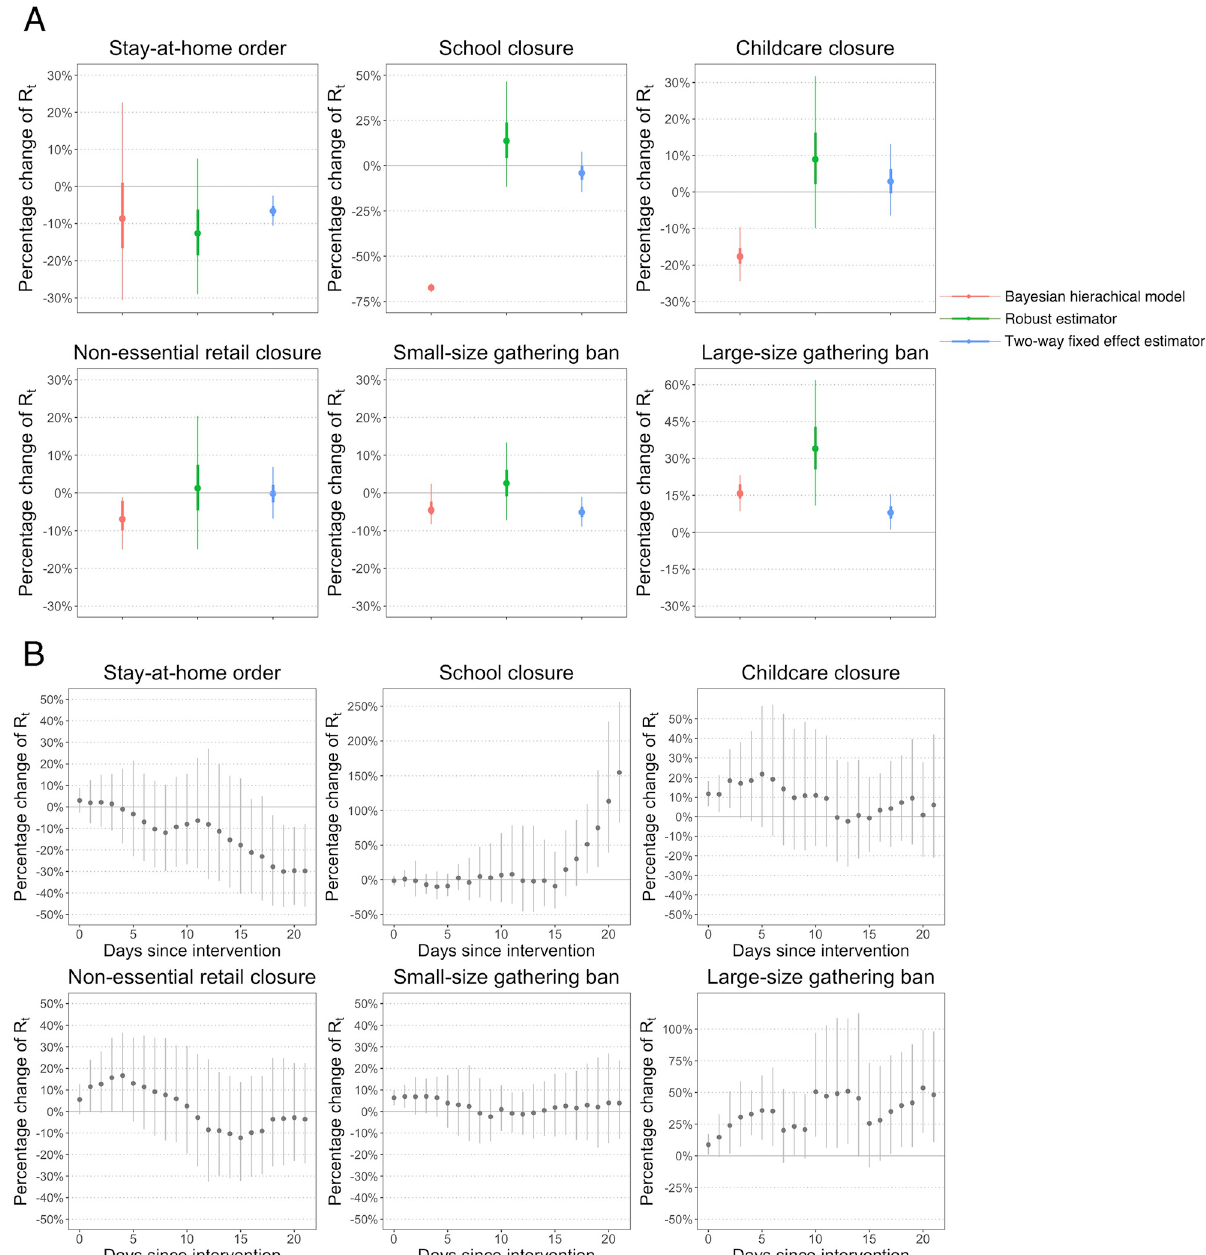
Fig 3. Intervention effect estimates from different modelling approaches. (A) Comparison of the results from the three approaches, with 50% and 95% confidence intervals. The Bayesian hierarchical model tends to produce the larger effect estimates, since the effects of simultaneous voluntary behavioral changes could be taken by the model. The results produced by the two difference-in-difference estimators are closer to each other, yet the robust estimator has wider confidence intervals. (B) Time-varying intervention effects estimated by the robust difference-in-difference estimator with 95% confidence intervals. It shows that stay-at-home order has an increasing effect over